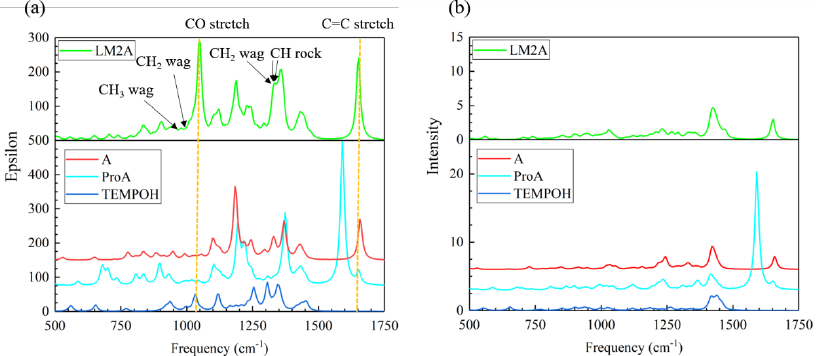
Figure 3. Calculated ( a ) IR and ( b ) Raman spectrum for each species in the enamine reaction pathway. The half-width at half height of IR and Raman peaks is 10 cm − 1